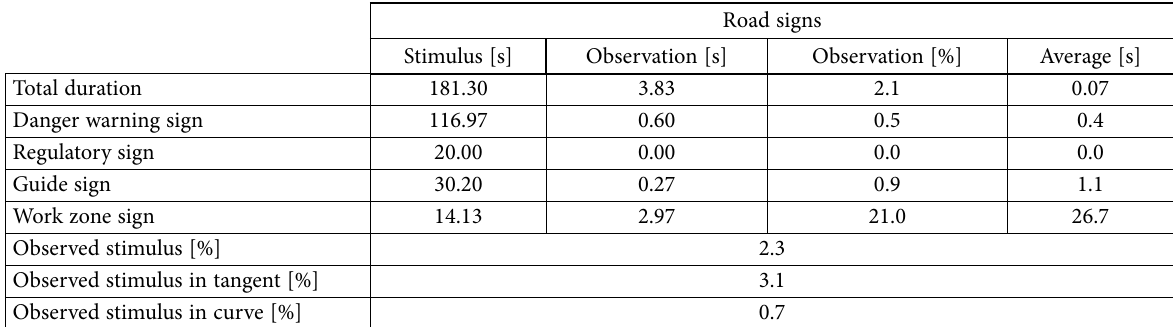
Table 5. Characteristics of the driver’s glance about the vertical signs during the travel